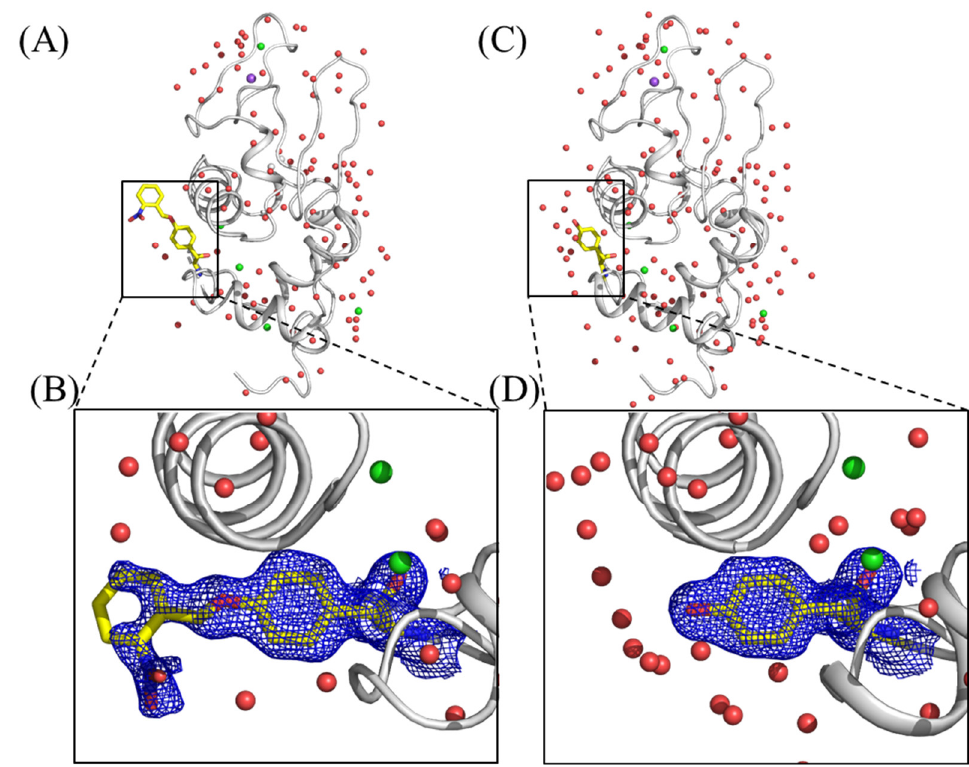
Figure 4. Crystal Structures of hen egg-white lysozyme (HEWL) with the incorporation of o NBTyr before ( A ) and after ( C ) photoactivation. Close-up views of the o NBTyr; ( B ) and decaged o NBTyr, Tyr; ( D ) at position 20 of HEWL are shown by stick yellow models. The |2F o − F c | electron density maps (0.6 σ) around Tyr20 are depicted by blue mesh. Water molecules, sodium, and chloride atoms are shown by red, purple, and light green spheres, respectively.